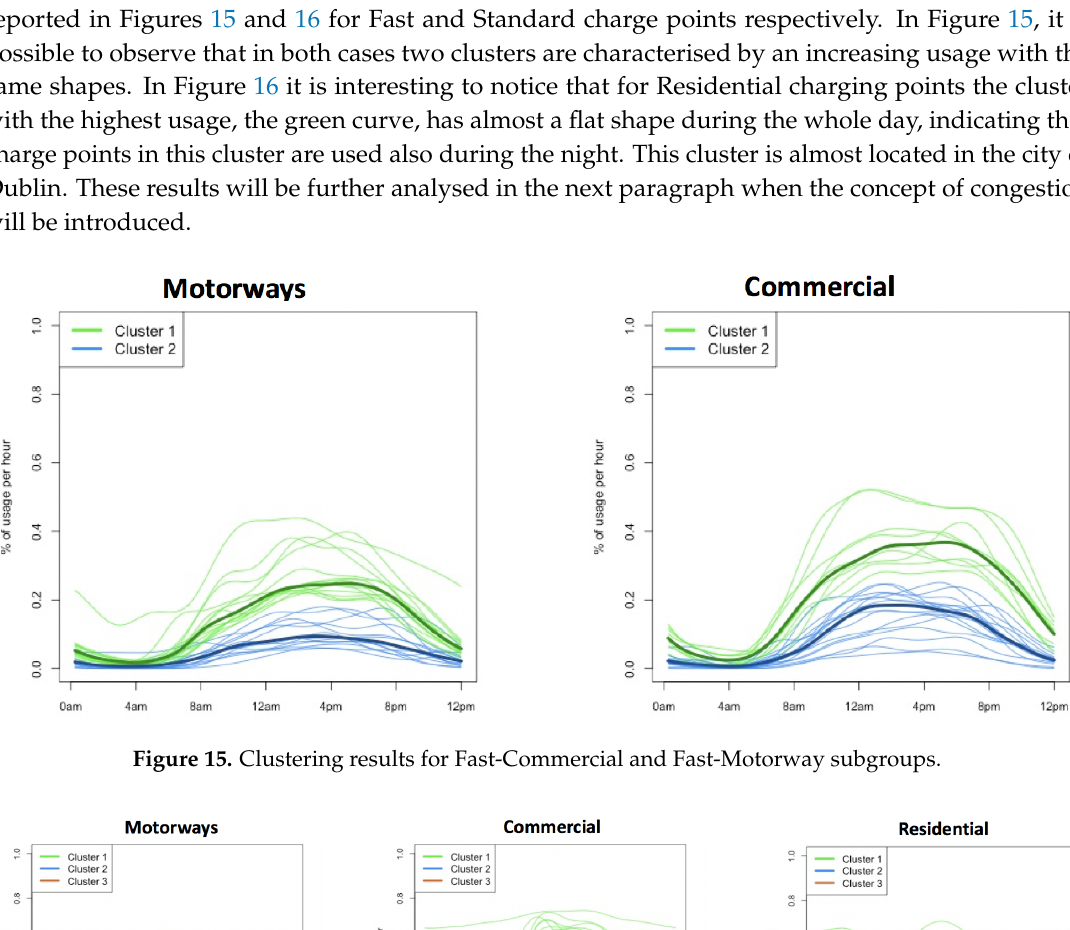
Figure 16. Clustering results for Standard-Commercial, Standard-Motorway and Standard-Residential subgroups